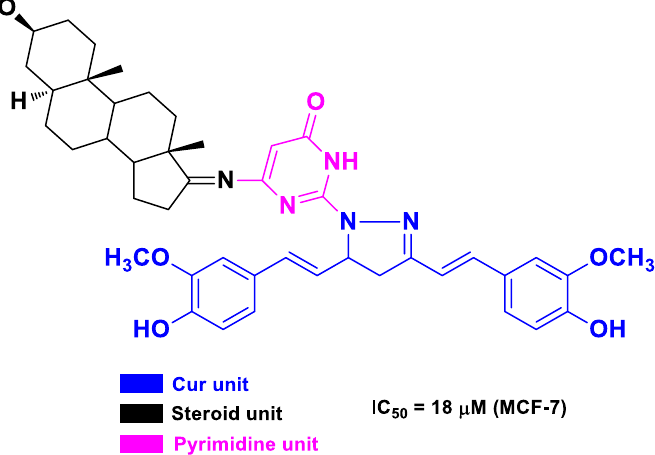
Figure 13. Structure and activity of the hetero-steroid–Cur hybrid developed by Elmegeed’s research group [61].